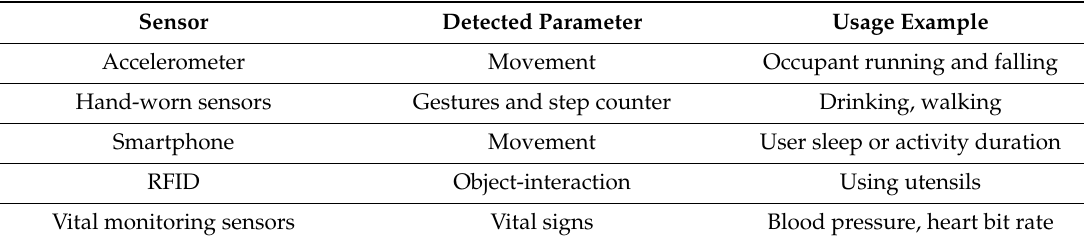
Table 4. Wearable sensors used for activity